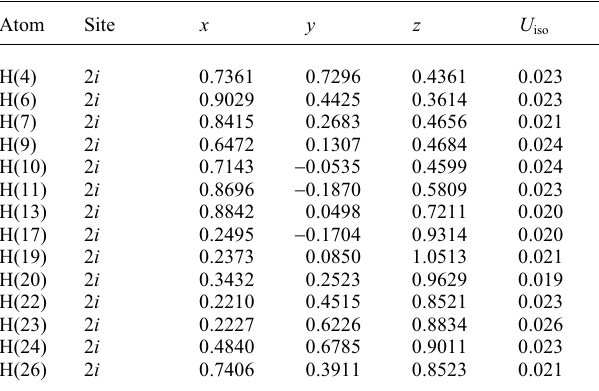
Table 2. Atomic coordinates and displacement parameters (in Å 2 )